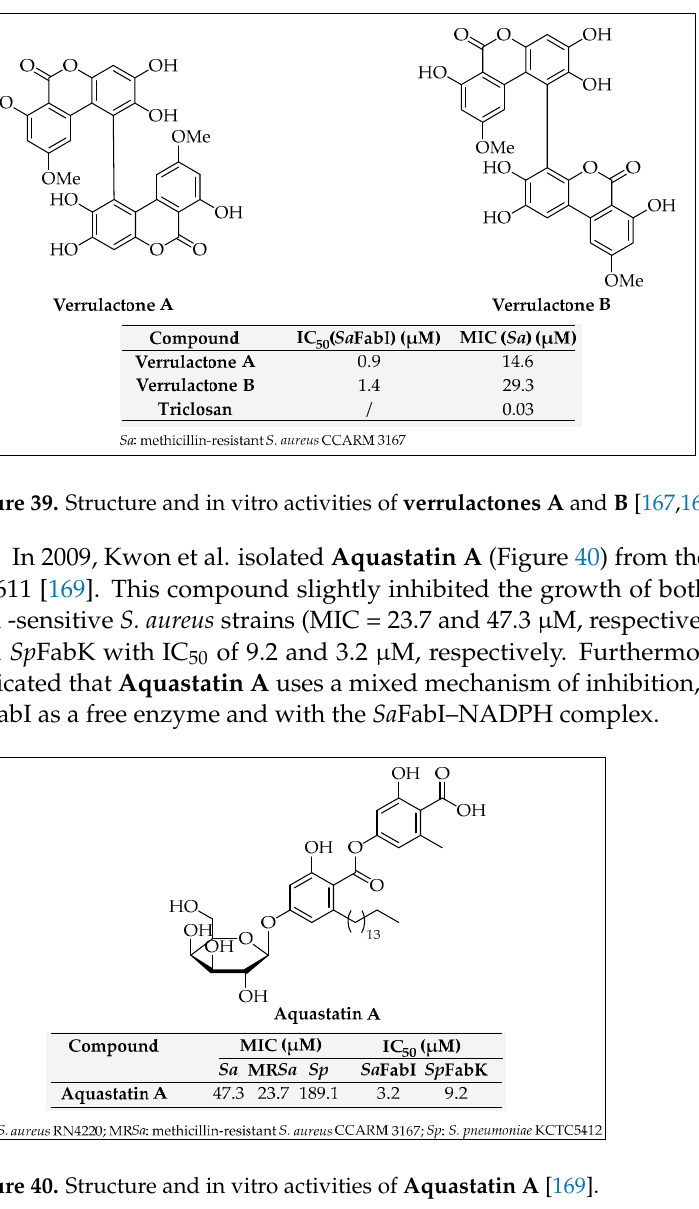
Figure 40. Structure and in vitro activities of Aquastatin A [169].